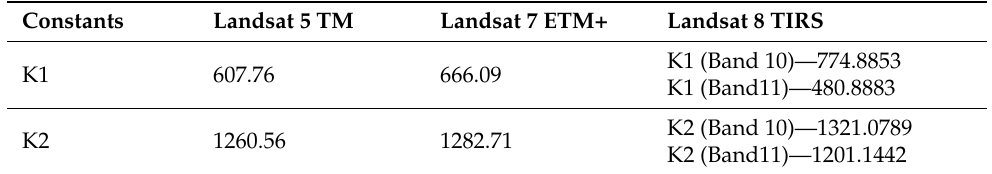
Table 2. Constant values of Equation (10).